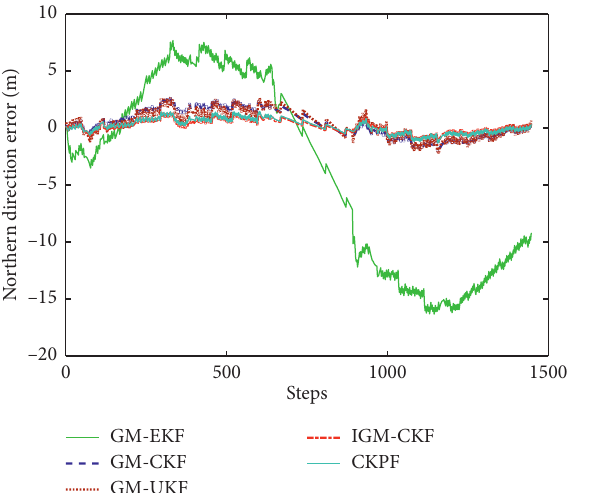
Figure 7: Comparison of the errors in the eastern direction using 39,000 data points.